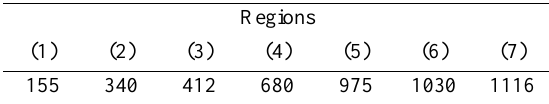
Table 2 . Distances from Eskisehir City to the Centers of the Regions(km)